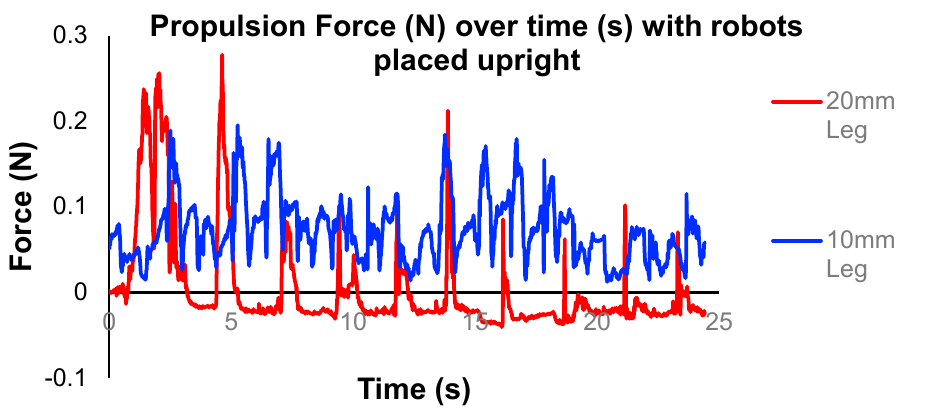
Figure 17. Propulsion forces for repeated movement using SLEM-20 and SLEM-10. A copper string is attached to the legs. The 20 mm legs show greater propulsion forces but are much more unstable when placed upright than the 10 mm legs over repeated movement. The shorter 10 mm legs are also much easier to be actuated and therefore actuation frequency is higher, which might affect the value of force measured.